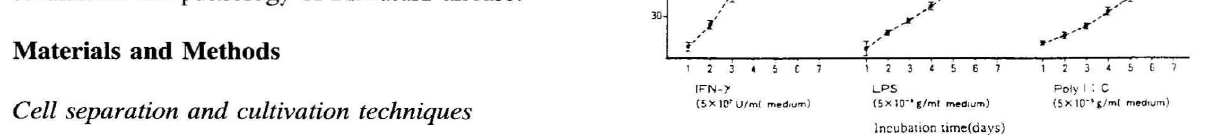
Figure 1. Neopterin production by M<I>/M upon stimu lation by activators. The M<I>/ M were obtained fTom a healthy adult volunteer by the method described in the text. Incubation was carried out in 2 ml RPMI 1640 sup plemented with 15% autologous serum and stimulants respectively. A 100 fJ.l quantity of each of the superna tants was collected once daily up to the 7th day for analysis of neopterin by